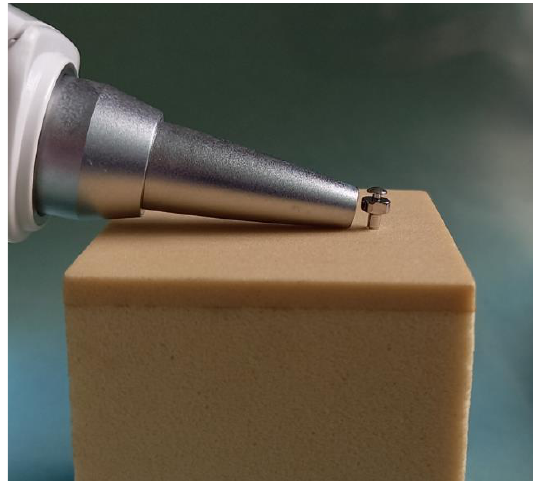
Figure 5. Tapping head device of the Periotest system (Periotest M, Medzintechnik Gulden, Modautal, Germany) to percuss the microimplant.